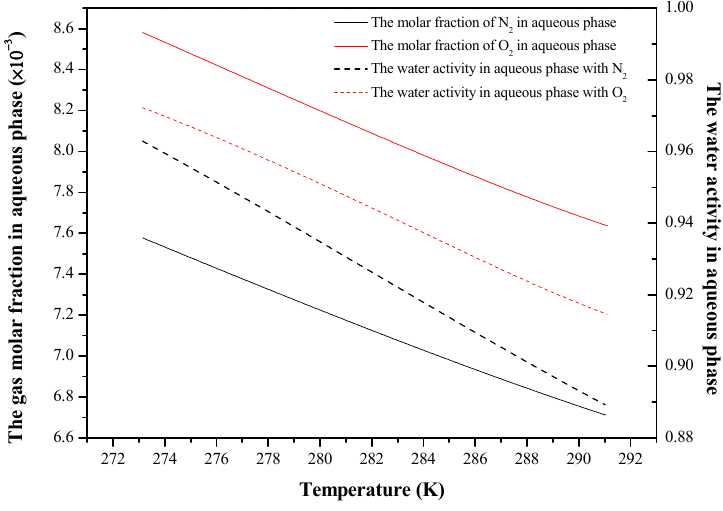
Figure 5. The mole fraction of N 2 /O 2 and water activity in aqueous phase.